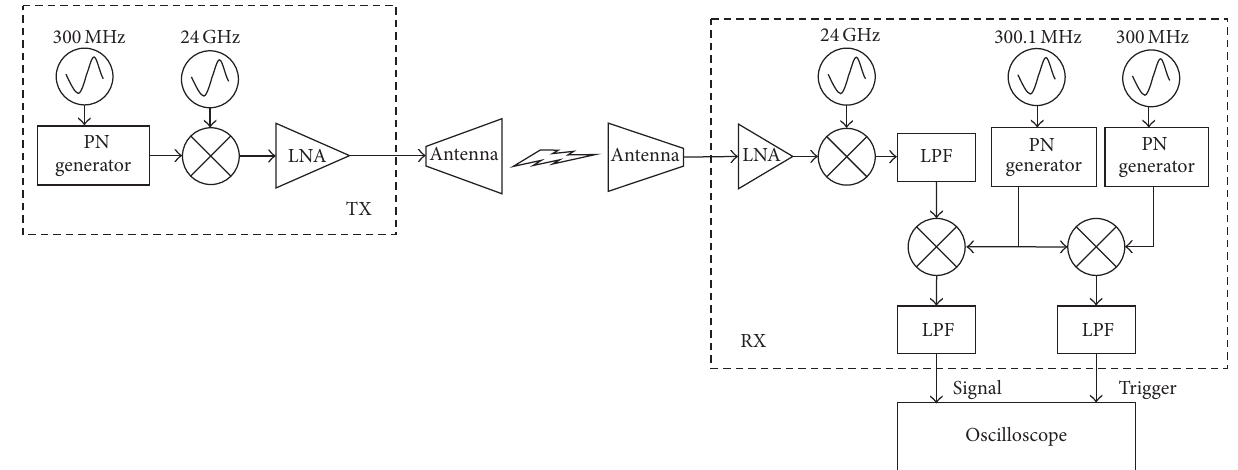
Figure 1: A schematic diagram of a sliding correlator used in the channel sounding. The oscillators are synchronized by an external 10MHz reference clock which is not shown in the